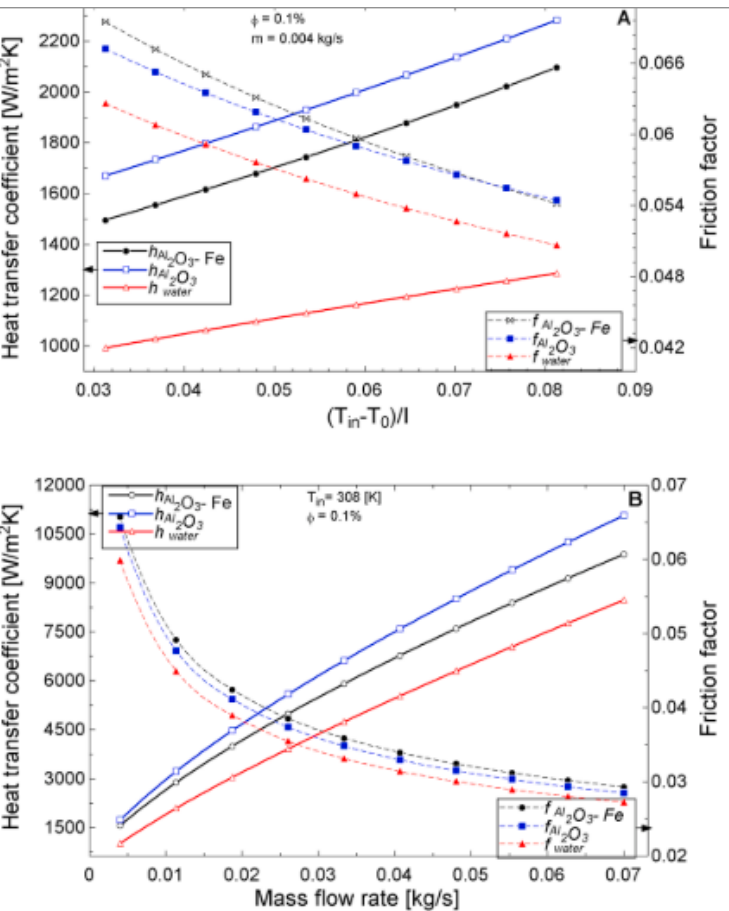
Figure 11. Thermal and exergetic efficiency performance of Al 2 O 3 ‐ Fe and Al 2 O 3 nanofluid and water against increasing volumetric fraction for a flat plate collector application (Adapted from Okonkwo et al. [112]).